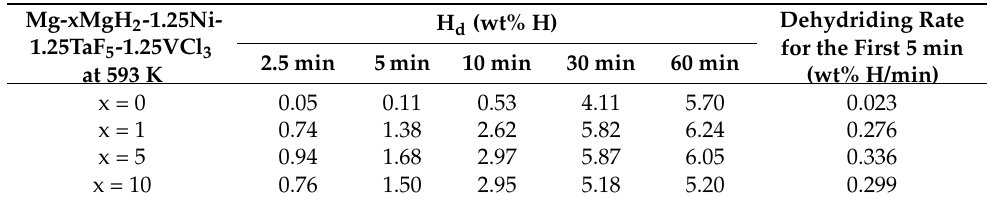
Table 2. Variations of the H d with time and the dehydriding rates for the first 5 min at 593 K under 1.0 bar H 2 at n = 1 for Mg-xMgH 2 -1.25Ni-1.25TaF 5 -1.25VCl 3 (x = 0, 1, 5, and 10).